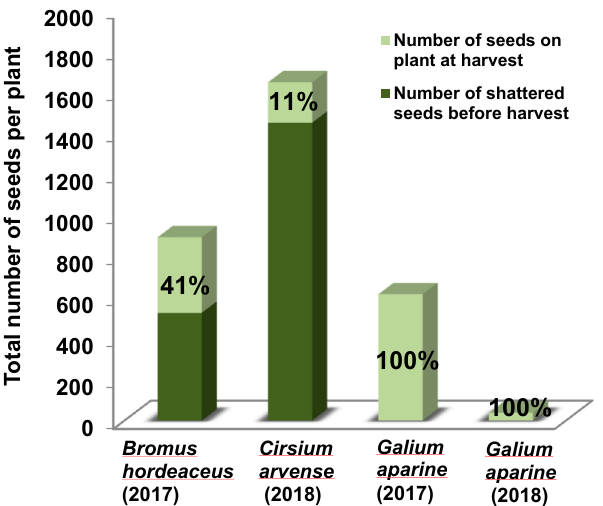
Figure 4. The total number of seeds and number of seeds shattered before wheat harvest of Bromus hordeaceus , Cirsium arvense and Galium aparine .